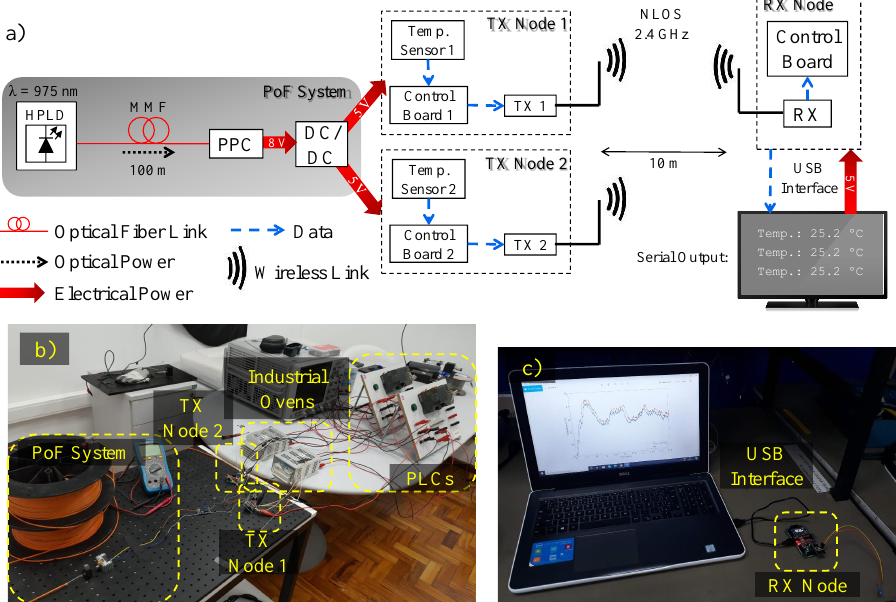
Figure 5. Optically-powered wireless TX sensor nodes implementation. ( a ) Experimental setup block diagram. ( b ) Experimental setup photograph of PoF system, TX nodes, industrial oven and PLC. ( c ) Experimental setup photograph of RX node, USB interface and the computer. HPLD—high- power laser diode; MMF—multimode fiber; PPC—photovoltaic power converter;